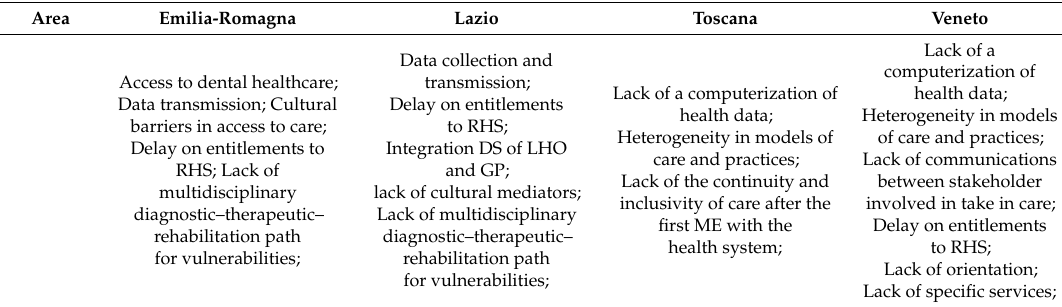
Table 4. Summary of checklists: